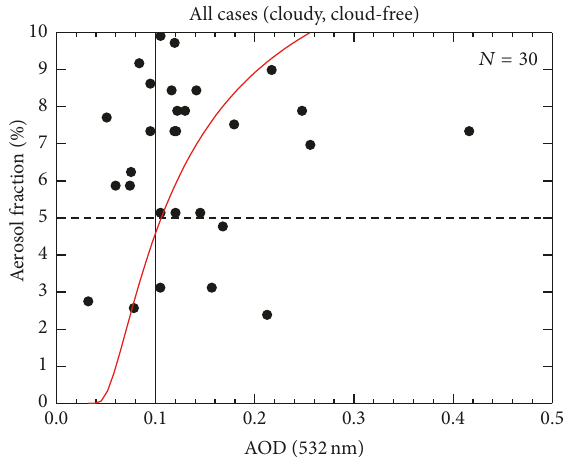
Figure 5: The relationship of AOD at 532 nm and aerosol fraction during CALIOP overpass. The fitting result of the data points (red solid